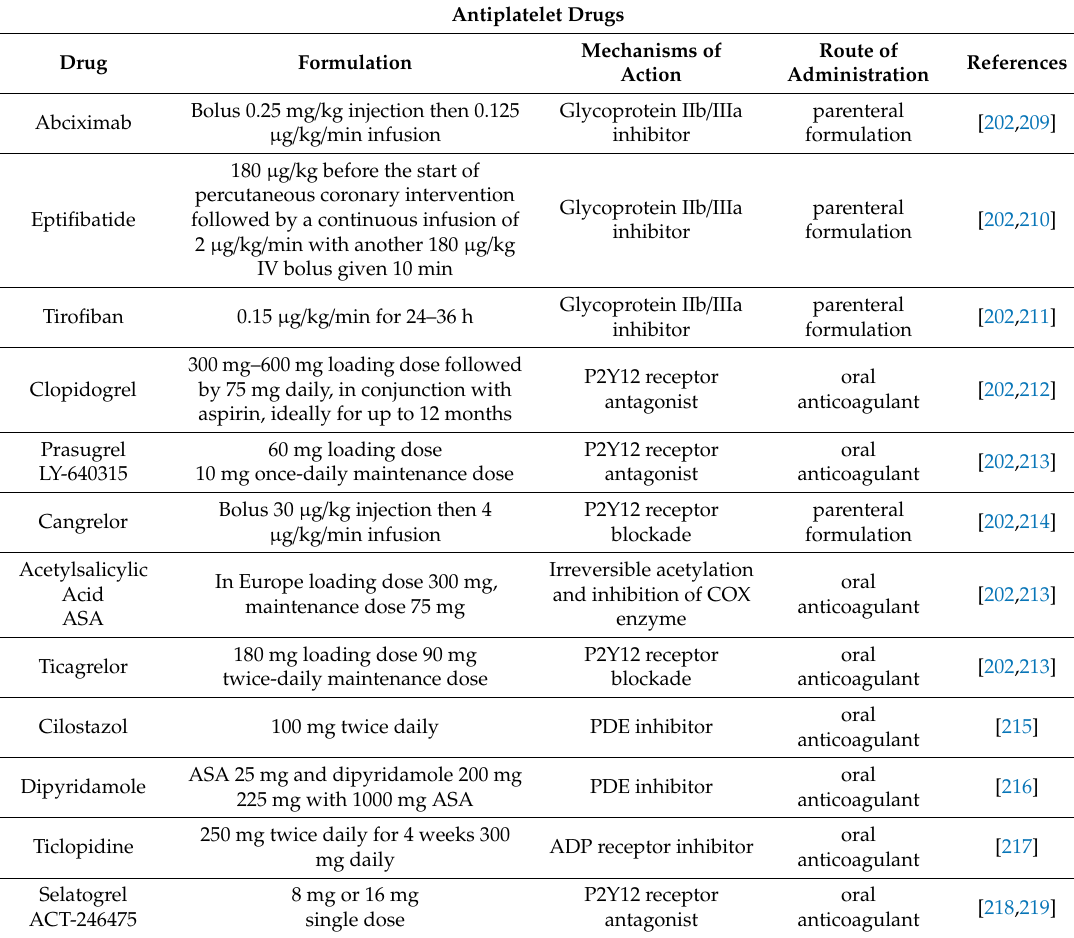
Figure 11. Antiplatelet drugs which selectively and reversibly bind to the platelet IIb/IIIa receptor glycoprotein: eptifibatide (29) and tirofiban (30). Table 2. Antiplatelets drugs in the treatment of atherothrombosis, the doses used, and the receptor inhibitors/antagonists.